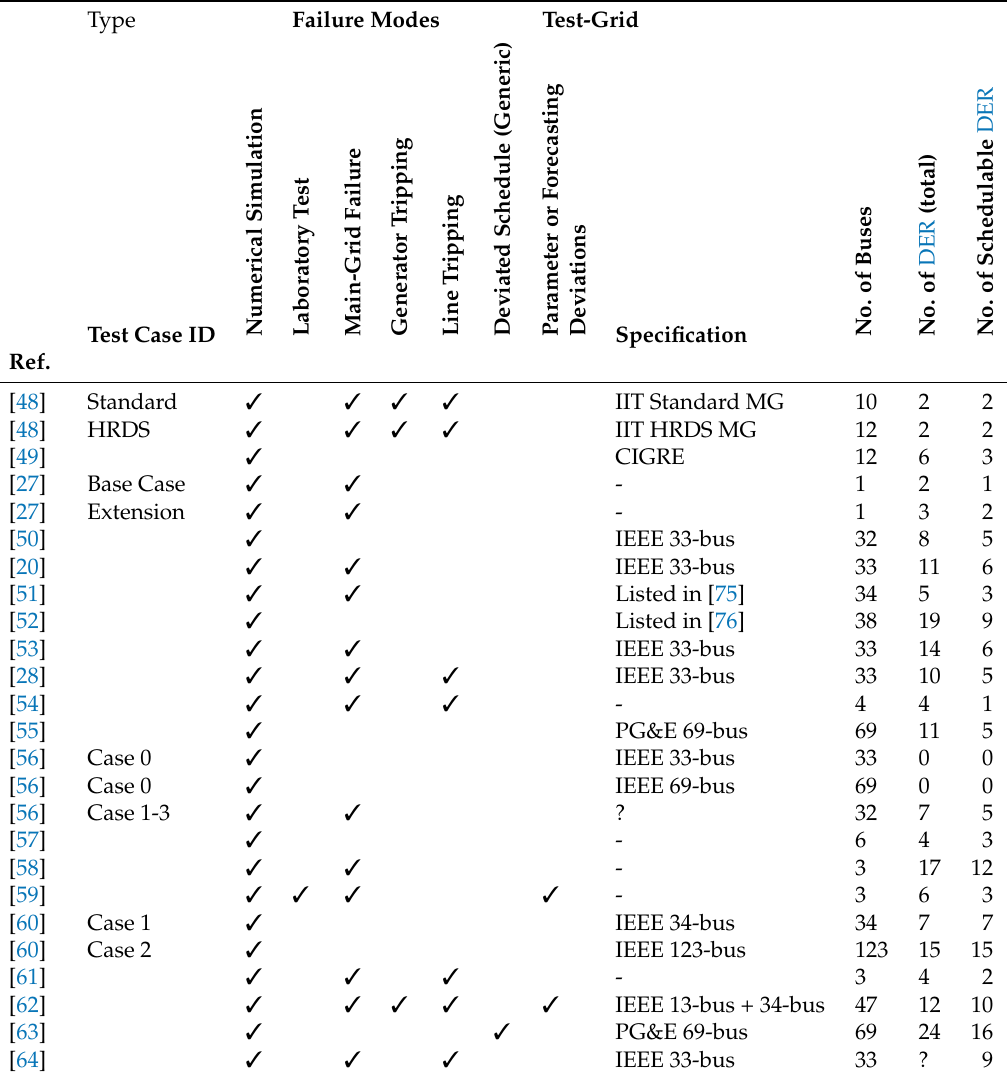
Table 8. Validation approaches ( (cid:51) : Implemented, ?: Not reported)